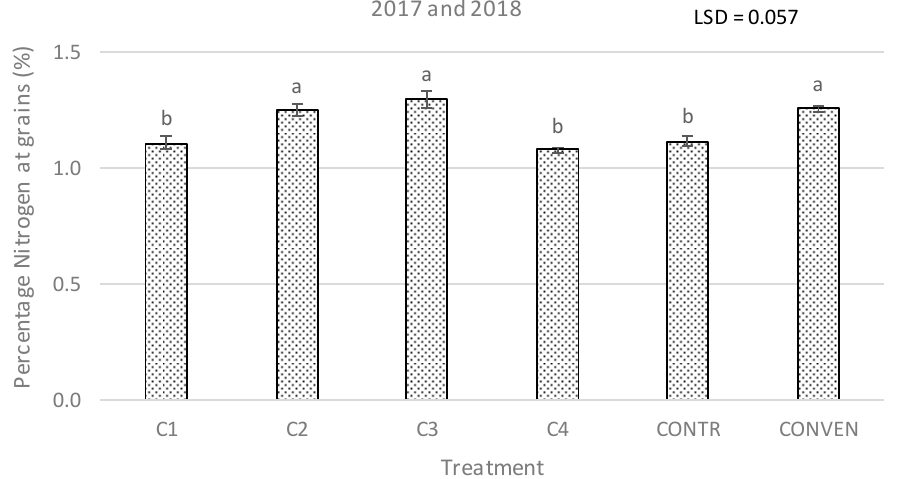
Figure 10. Percentage nitrogen at grains (means ± se) harvested by rice plants grown in differently fertilized soil of the experiments during 2017 and 2018. Treatments contain compost application of (i) 80 kg ha − 1 N in split application (C1), (ii) 160 kg ha − 1 N in split application (C2), (iii) 320 kg ha − 1 N in split application (C3), (iv) 160 kg ha − 1 N in single application (C4), (v) an untreated control (CONTR), and (vi) 160 kg ha − 1 nitrogen chemical fertilizer (CONVEN). Means were compared by the Bonferroni adjusted LSD value at p < 0.05. Different letters characterize significant differences between treatments. Full description of the treatments examined is found in Table 3.